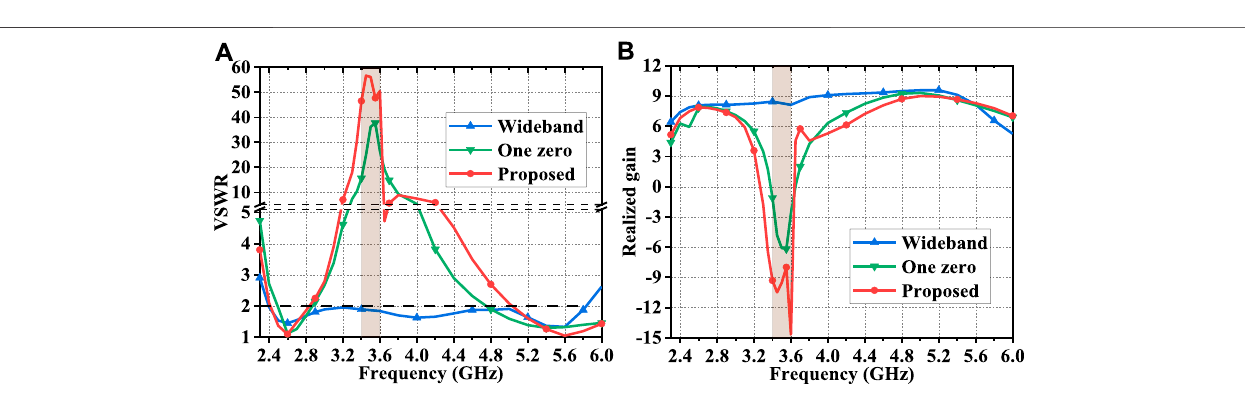
FIGURE 11 | Simulated (A) VSWR and (B) realized gain of three antennas.